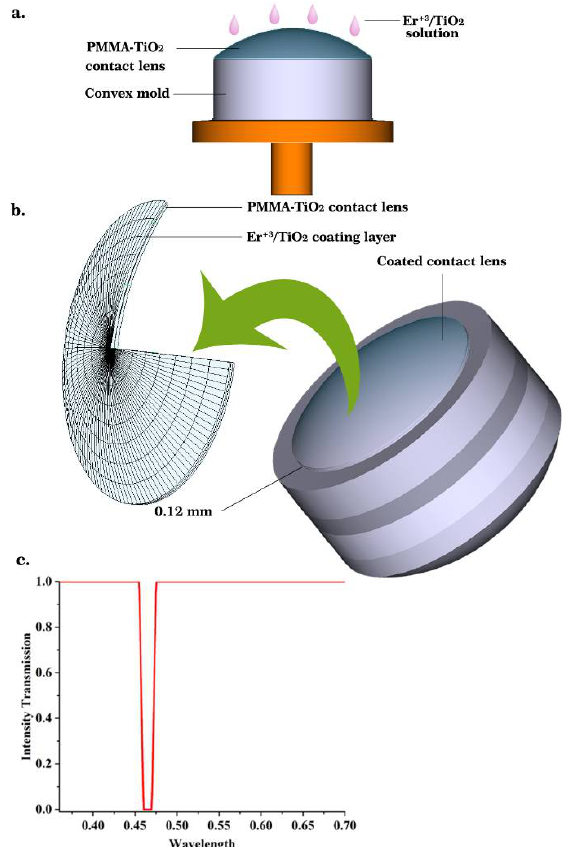
Figure 7. ( a ) Spin-coating a contact lens with 0.6 wt/vol % Er 3+ /TiO 2 solution; ( b ) The layers of the resulting contact lens; ( c ) intensity transmission as a function of wavelength blocking 0.45–0.47 nm from transmission.